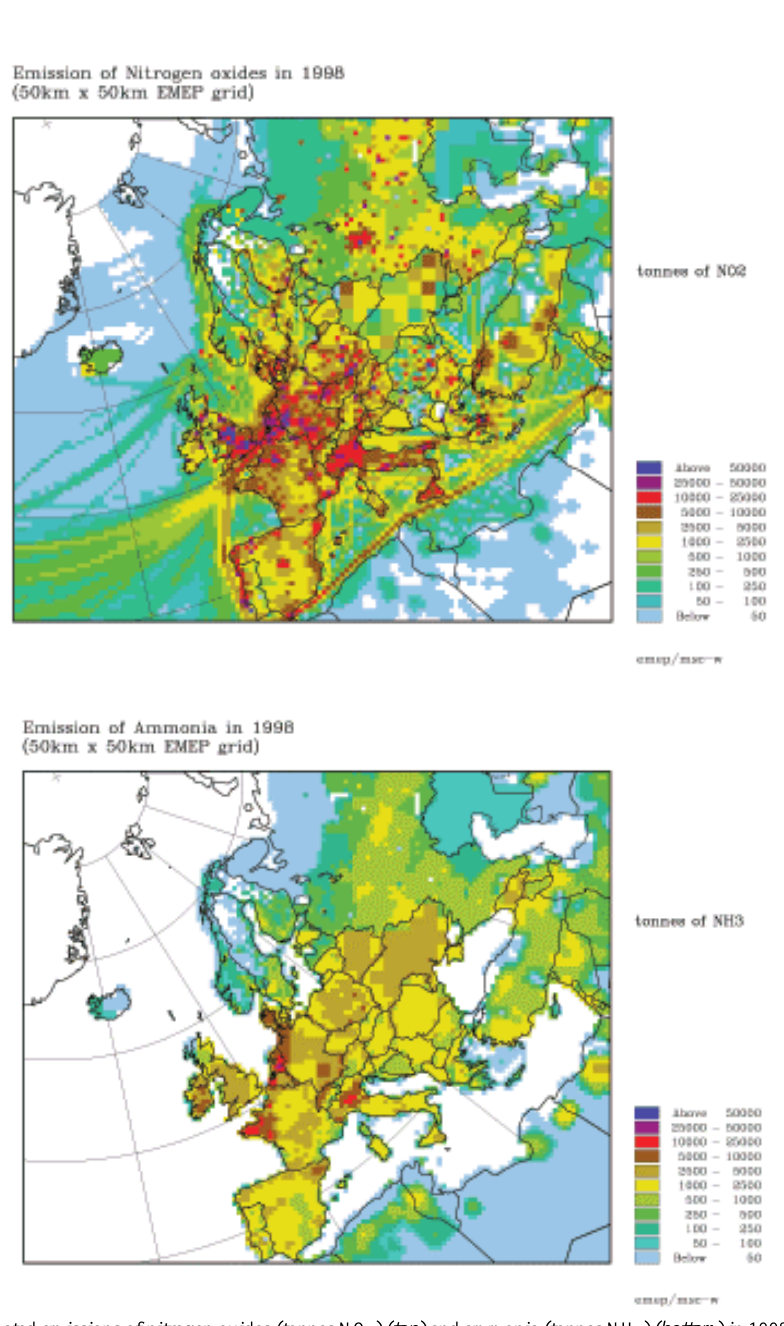
FIGURE 1. Estimated emissions of nitrogen oxides (tonnes NO 2 ) ( top ) and ammonia (tonnes NH 3 ) ( bottom ) in 1998 at 50 km resolution in